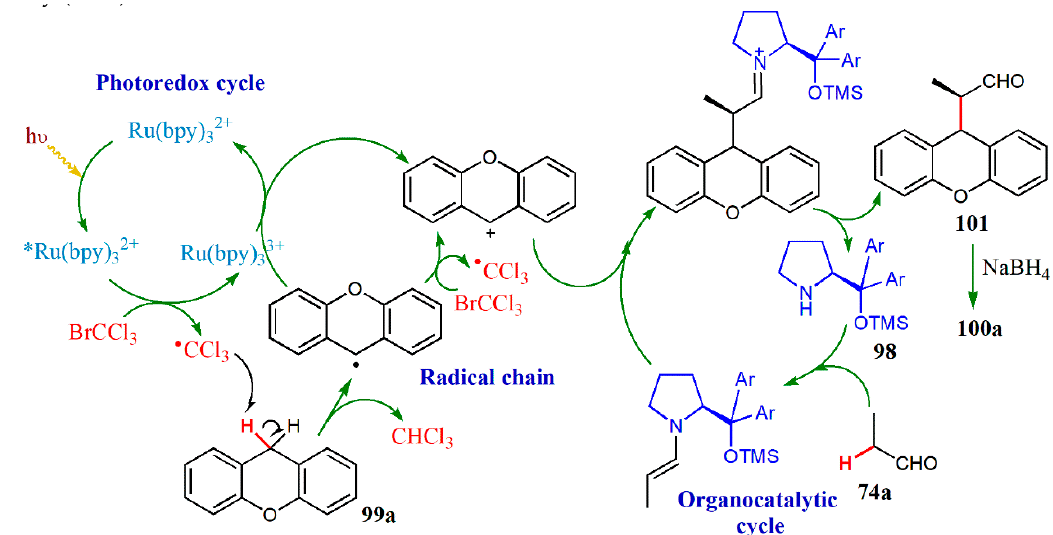
Figure 31. The mechanism proposed for the enantioselective CDC of aldehydes with